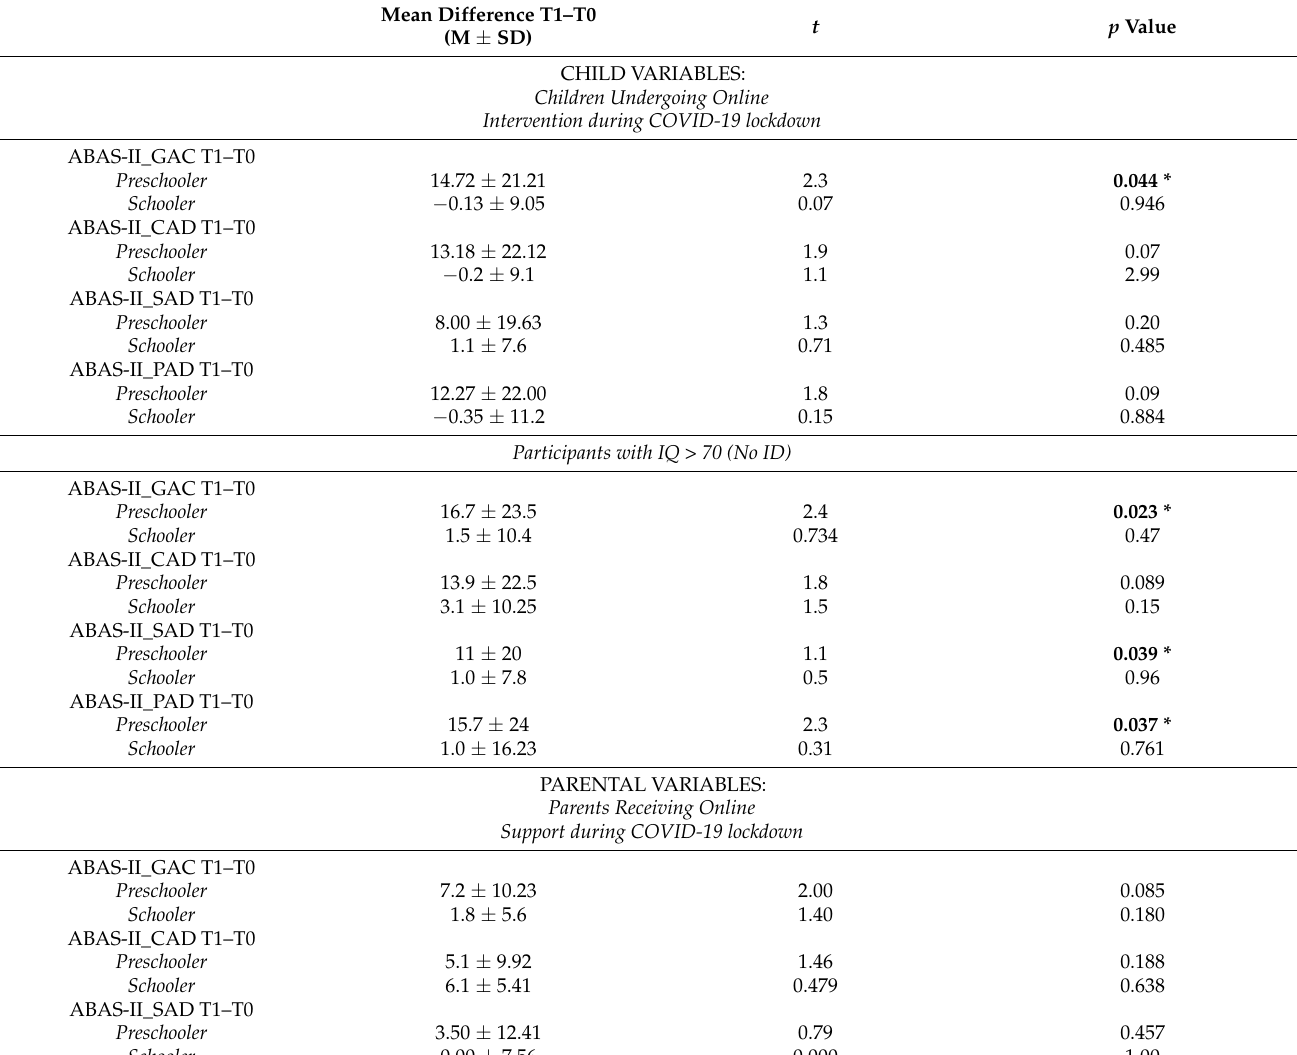
Table 3. Improvement in adaptive skills: relation to parental and child variables within the preschooler and schooler group.